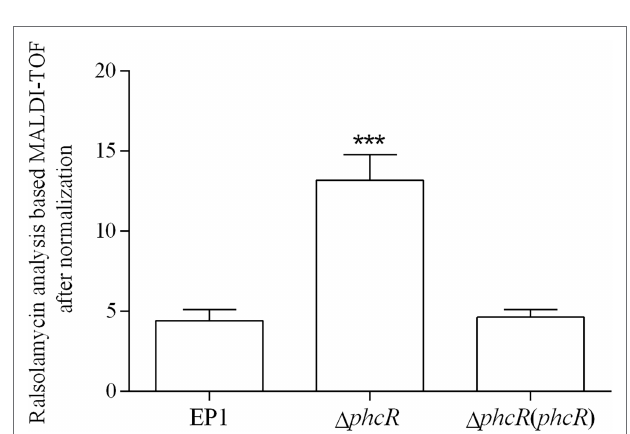
FIGURE 4 | matrix-assisted laser desorption ionization time-of-flight spectrometry analysis of ralsolamycin production in wide type strain EP1, phcR deletion mutant ( Δ phcR ) and complementary strain Δ phcR ( phcR ). Presence of the peak in the bacterial extract showing the accurate mass of ralsolamycin ( m / z 1291.7142) was identified, and the corresponding peak areas of wild type and mutants were compared and calculated. Each assay was repeated for three independent experiments with four replications per trial. The natural log data obtained were analyzed using FlexAnalysis 3.0 software. Mean values of all experiments were averaged with SD (error bars) and statistical significance was assessed using a paired two-tailed Student’s t -test by using the GraphPad Prism 6.0 software. *** means p ≤